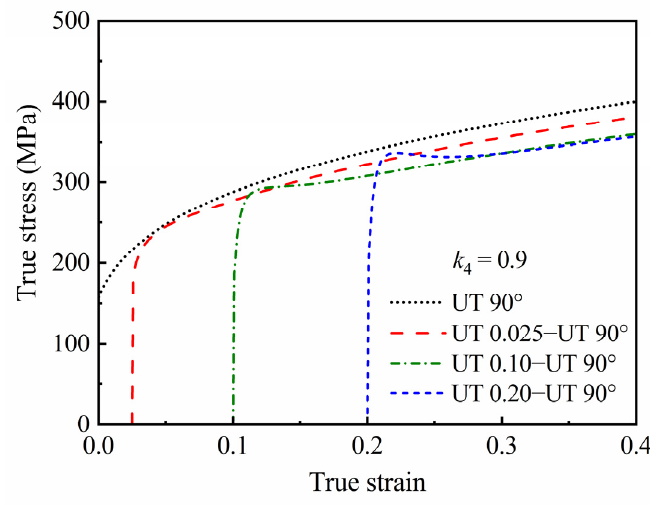
Figure 12. Stress–strain curves predicted by the HAH-2d model in two-step uniaxial tensions with tensile axes at 45° from each other.